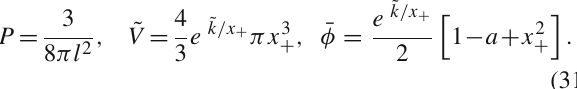
for a = 0 . 1 (right). For a = 0 . 6, ˜ T max = ˜ T min at x = 0 . 210 for ˜ k = 0 . 0702728 whereas for ˜ k = 0 . 1, ˜ T a c = 0 .